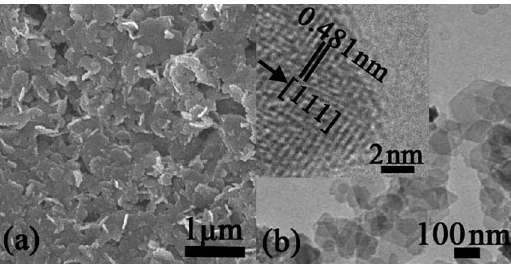
as a function Q V O 2 4